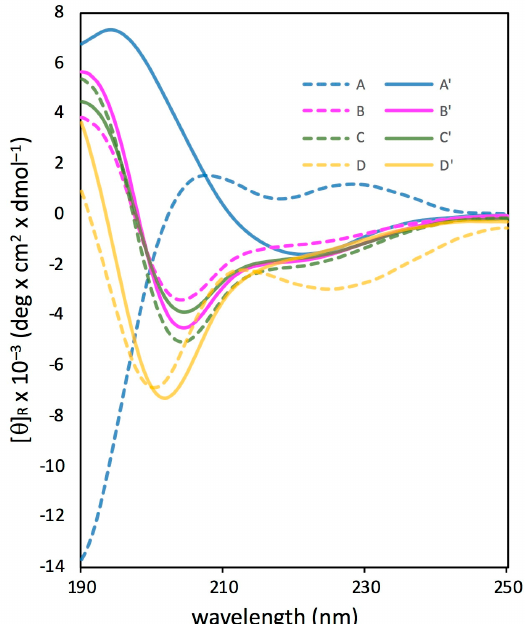
Figure 2. Circular dichroism (CD) spectra of peptide catalysts A – D and A’ – D’ . (0.5 mM in 2,2,2- trifluoroethanol).